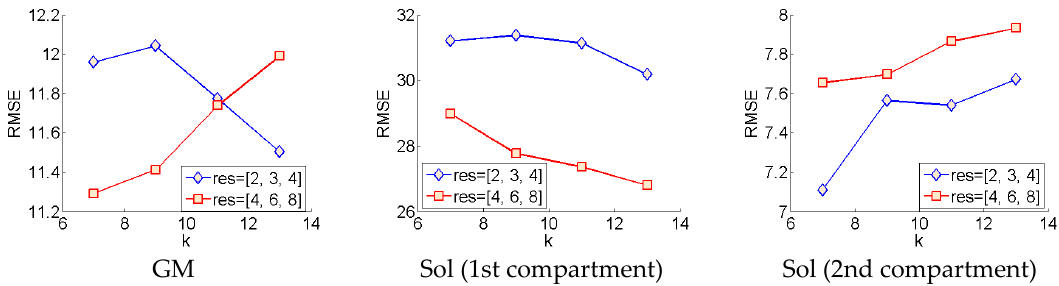
Figure 2. Wavelet parameter tuning. This graphic depicts how the error changes with respect to the parameters of the Frangi filter (res) and the Gabor wavelet filters (k).